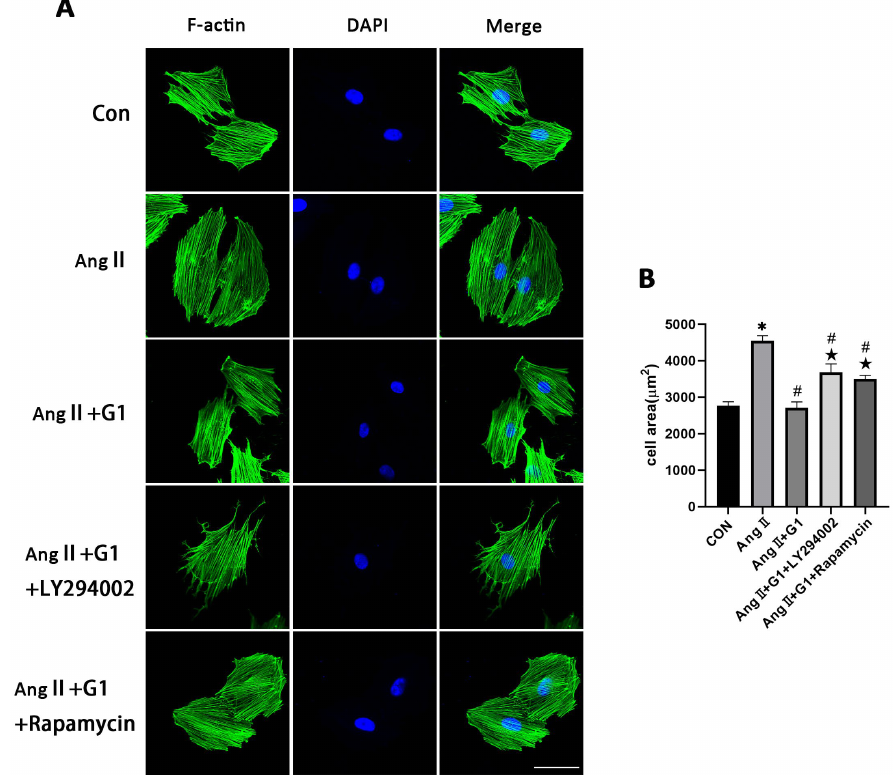
Figure 10. Effect of LY294002 or rapamycin on cardiac hypertrophy of H9c2 cells in the AngII + G1 group. ( A ) Representative confocal microscopy images of the H9C2 cells by Phalloidin Staining (scale bar = 50 µm). ( B ) cell area of H9c2s from indicated groups. The data is expressed as mean ± SEM and was analyzed by one-way ANOVA (n = 4). * p < 0.05 vs. Con; # p < 0.05 vs. AngII; (cid:70) p < 0.05 vs. AngII + G1.